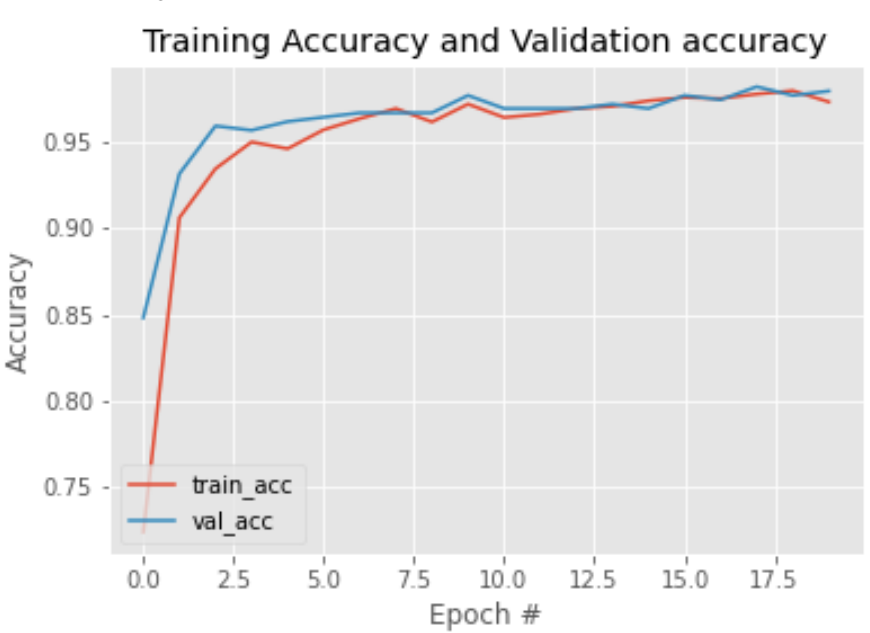
Figure 8. Training and validation loss.